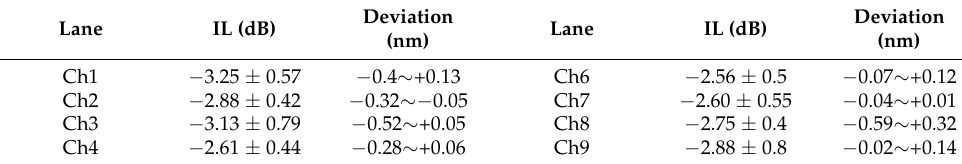
Table 4. Statistical distribution in terms of insertion loss and deviation for all channels.